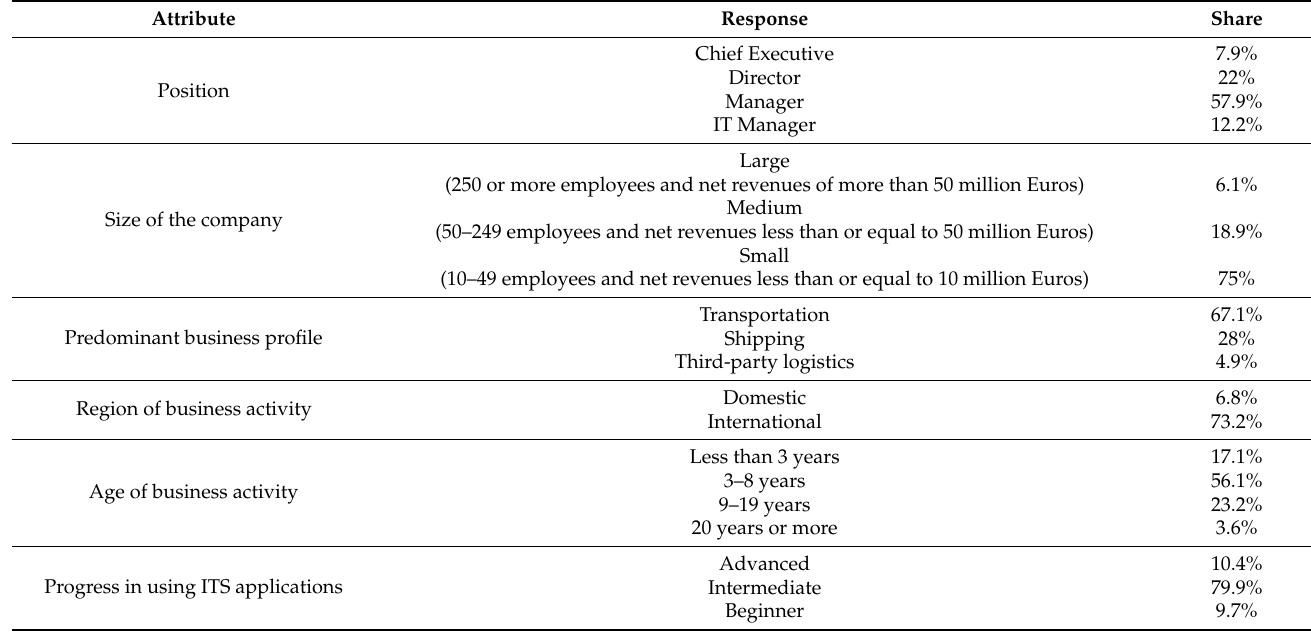
Table 1. Fundamental attributes of the responding